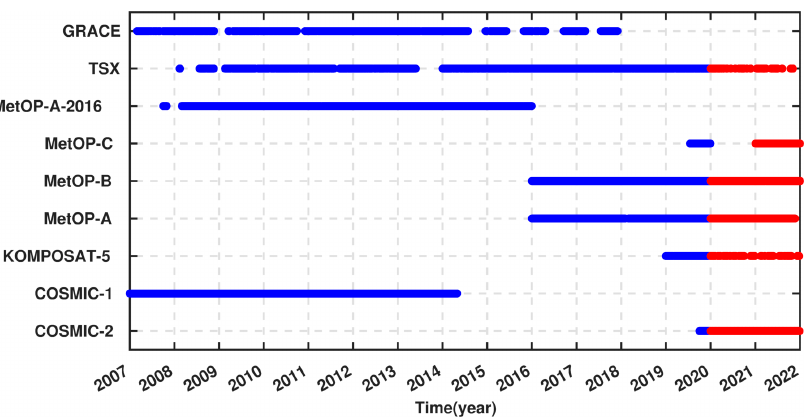
Figure 2. An overview of the availability of RO observations over Iran, covering 2007–2022. The blue color indicates observations that are used for training the ELM and those in red represent those applied for testing the outputs of ELM.